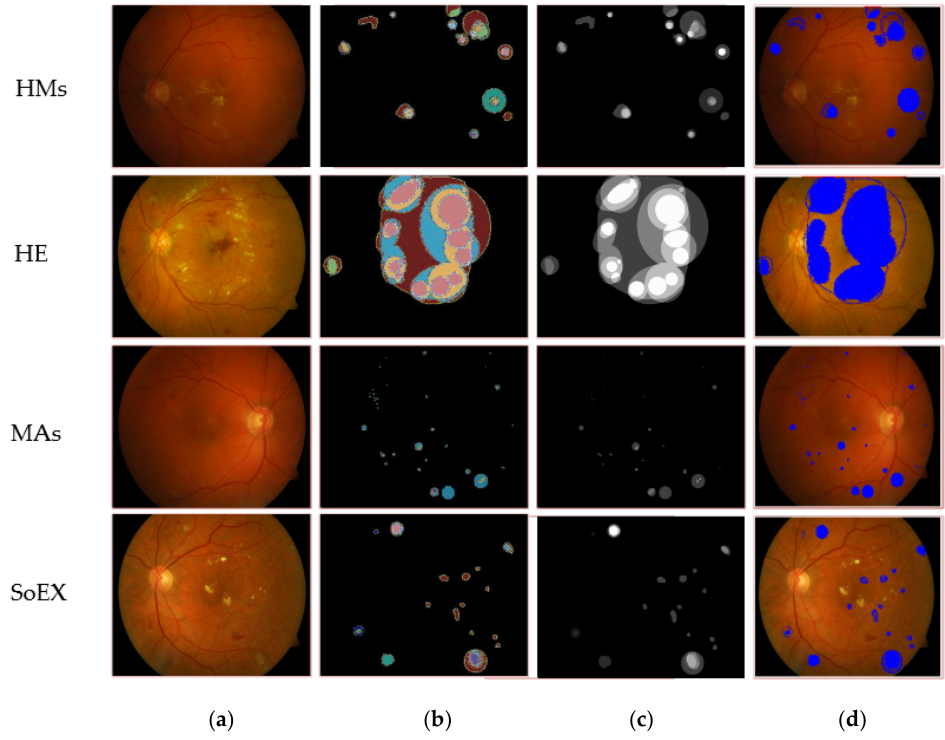
Figure 6. Segmented DR lesion outcomes on DIARETDB1 dataset. ( a ) Input image, ( b ) proposed segmentation, ( c ) ground truth image, ( d ) segmented region mapped on the input image.